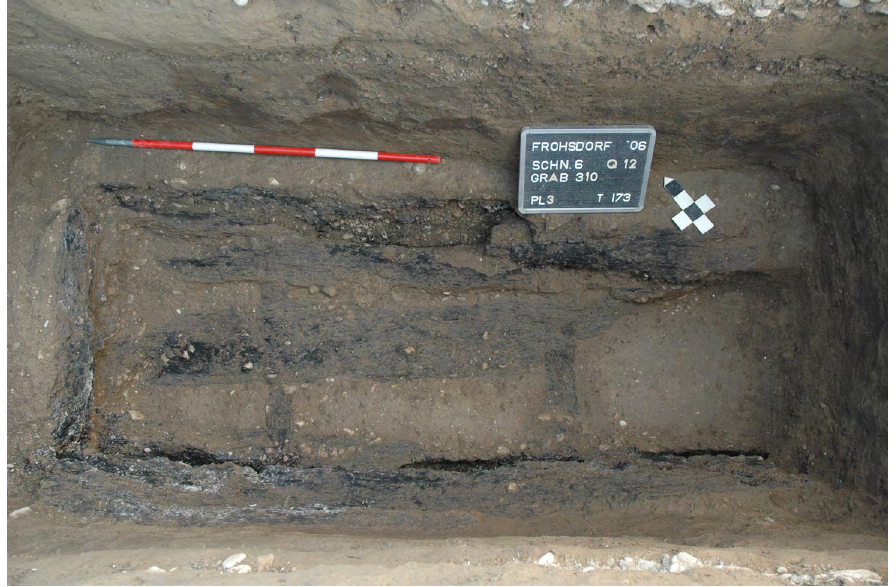
Figure 2: Grave 310 with coffin made of wooden planks (photo: Döme Jankovich)